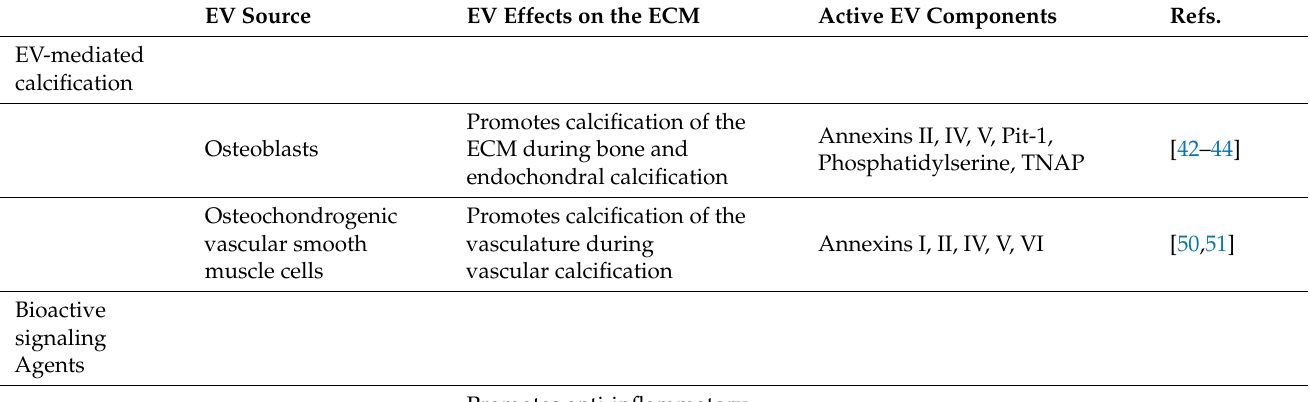
Table 1. Direct EV-ECM